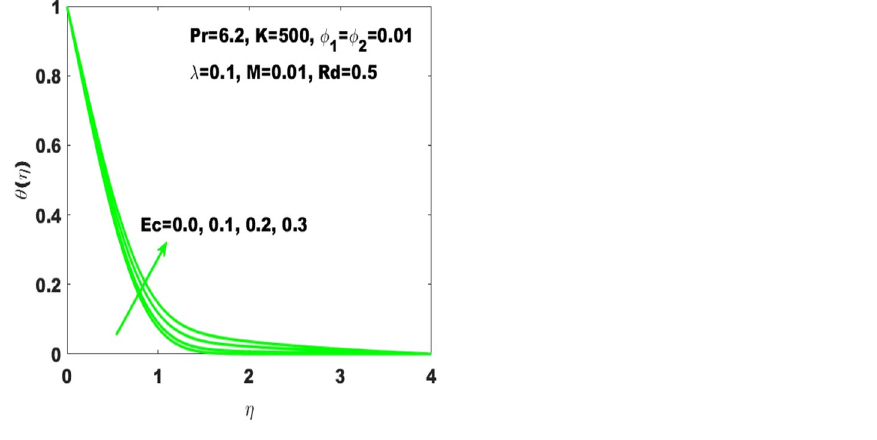
Moreover, it is obvious that higher surface stretching is more sensitive to the rate of heat transfer. In Fig. 3, it is noticed that the rate of heat transfer is affected intensively due to the change in Hartmann number ( M ) as it is enormously enhancing due to the slight boost in M . In the absence of magnetic field, the heat with a minimum rate is transferred. Considering high values of M slumps the fluid motion due to the magnetic field and thus the heat transfer rate is dominant. In the same way, Nusselt number ( Nu ) is dominant with higher rate of stretching. In addition, the Nusselt number is highly influenced by the radiation parameter subject to the increasing rate of surface stretching. Definitely the speeding up of the thermal radiation accelerates the rate of heat transfer as seen in Fig. 4. Most of the industrial, electrical, and electronic appliances may not work without the consideration of heat transmission. Therefore, the fluid motion considering the heat transmission is very important to utilize in such types of materials. The amendments in the fluid temperature profile θ ( η ) against the curvature parameter ( K ) is displayed in Fig. 5. The graphical observation indicates that the building up of curvature supports the fluid temperature to boost it alternatively stated that the plane surface is more effective in boosting of fluid temperature as the curved surface turns into the flat surface with K → ∞ Additionally, it may be observed that θ ( η ) is respectively higher and smaller corresponding to the case of PST and PHF providing the rise in curvature. Figure 6 is supposed to show that how θ ( η ) is controlled by variation in thermal radiation Rd . It is obvious that the fluid temperature profile has ascending behavior against the accelerating values of the Rd as the speeding up of thermal radaitions conveys larger heat towards the fluid and thus it causes to strengthen the thickness of thermal boundary layer. Accordingly, the fluid temperature leads to be ascended. It is also important to determine that how the divers values of Eckert number ( Ec ) lead to the change in fluid temperature θ ( η ) assuming the rest parameters at con- stant values. In this regard, θ ( η ) has been considered for four different values of the Eckert number displayed in Fig. 7. Where Ec = 0 leads to the minimum temperature as well as the escalation of Ec drives the temperature towards higher values. Basically, the kinetic energy ratio to the enthalpy of fluid stands for the Eckert number which imports that the escalation of Eckert number will boost the kinetic energy of the fluid and thus the fluid temperature enhances. The graphical result g ( η ) refers to the temperature field based on the PHF, and it is changeable under the con- sideration of different values of the radiation parameter ( Rd ) as displayed in Fig. 8. From this figure, it is obvious that g ( η ) has ascending behavior against the accelerating values of Rd as the speeding up of thermal radaitions conveys larger heat towards the fluid and thus it causes to strengthen the thickness of thermal boundary layer. Accordingly, g ( η ) leads to be ascended. In the same way, the changes in the g ( η ) against the curvature parameter ( K ) is demonstrated in Fig. 9. The graphical observation indicates that the building up of curvature supports the fluid temperature to boost it alternatively stated that the plane surface is more effective in boosting of fluid temperature as the curved surface turns into the flat surface with K → ∞ . The important point is that the fluid temperature is smaller than the temperature of the surface i.e., ( T w > T ∞ ) . Therefore, the distribution of temperature refers to the PST case is relatively smaller than the case of PHF considering the escalation in Ec . The assessment of skin friction coefficient (called friction drag) based on the varying values of the Hartmann number ( M ), curvature parameter ( K ) and nanoparticles volume fraction ( φ 1 , φ 2 ) has been subjected to the stretched surface respectively displayed in Figs. 10, 11 and 12. In Fig. 10, it is noticed that the skin friction coef- ficient ( C f ) is affected intensively due to the change in Hartmann number ( M ) as it is immensely enhancing due to the slight boost in M . In the absence of magnetic field, the lowest friction drag is generated. On the other hand, friction drag is ineffective with the higher rate of stretching. From Fig. 11, it is apparent that the friction drag is quite sensible to the surface curvature parameter as it slightly enhances with rising values of curvature paramter. Ultimately, one can declare that the skin friction coefficient is highest for the maximum values ( K → ∞ ) of the curvature parameter which affirms that the friction drag is dominant with the consideration of flat surface as the curved surface turns into the flat surface with K → ∞ . Additionally, it is noticeable that higher surface stretching